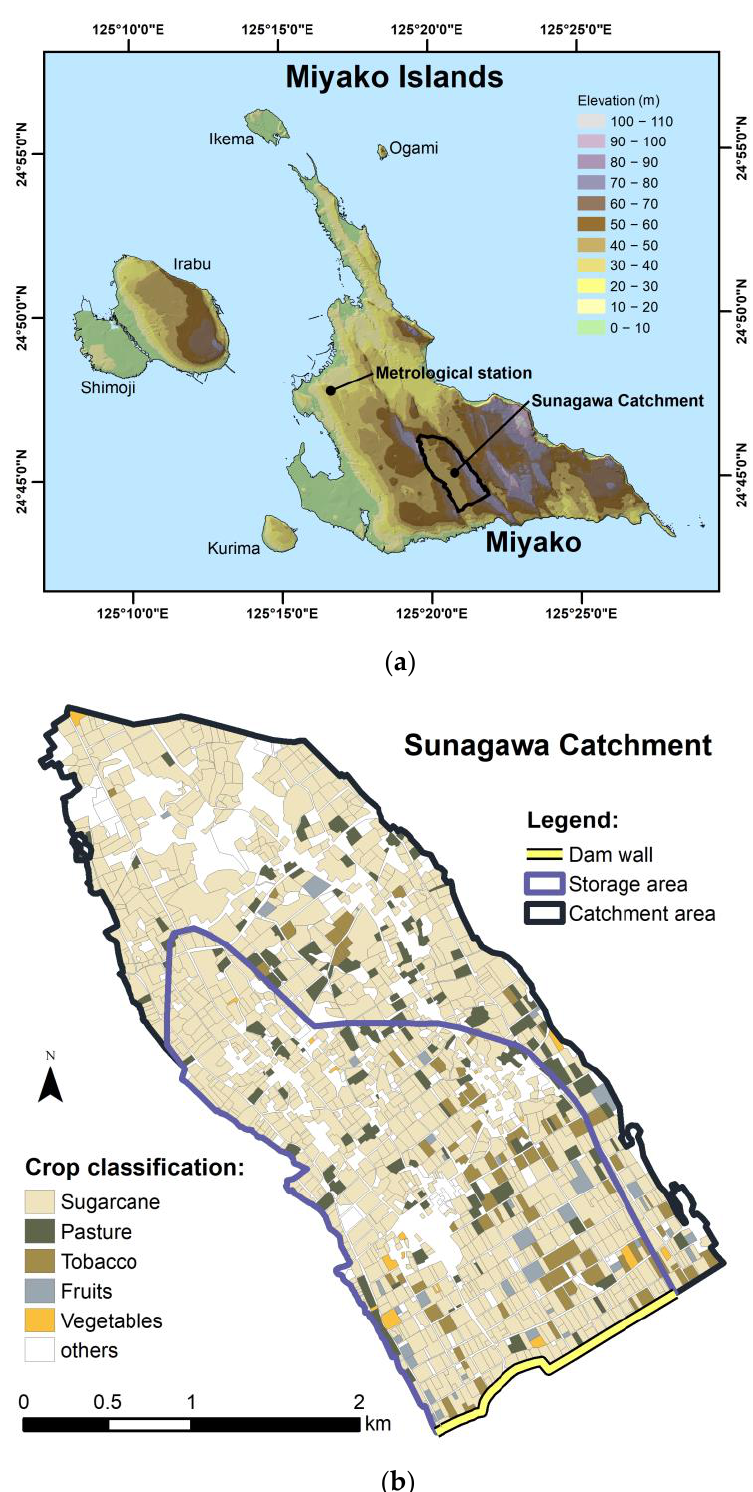
Figure 1. Maps of the study area: ( a ) topographical map of Miyako Island; ( b ) land use map for 2015 in Sunagawa catchment.